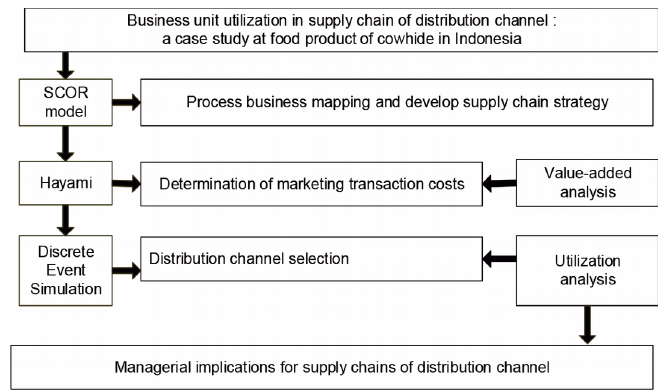
Figure 2. The stages of business unit utilization on the Supply Chain of Distribution Channel for food products of